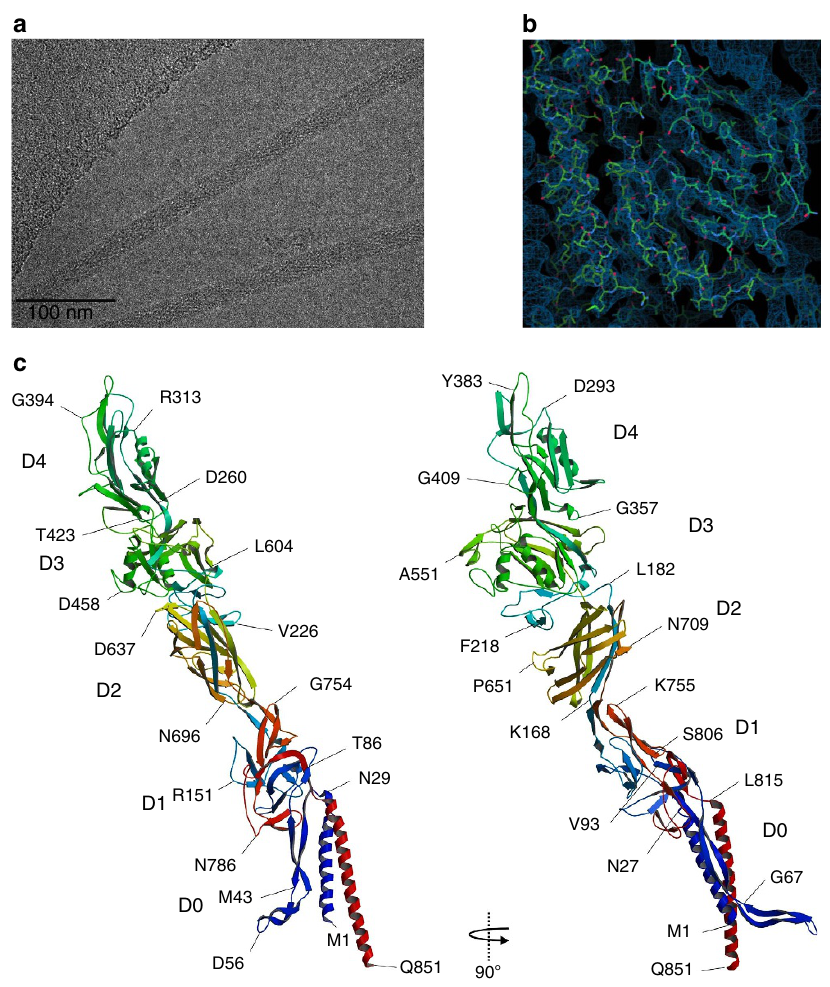
Figure 1 | Complete structure of FlgE from C. jejuni . ( a ) Cryo-electron micrograph of FlgEcj. ( b ) Cryo-EM density map superimposed with part of the structure of FlgEcj. ( c ) Two different views of the C a backbone tracing of FlgEcj with its five domains, D0, D1, D2 D3 and D4. The chain is colour coded in a spectral (‘rainbow’) sequence, from blue at the N-terminus through red at the C-terminus. Figure prepared Figure prepared with Coot 36 , MOLSCRIPT 44 and RASTER3D (ref.